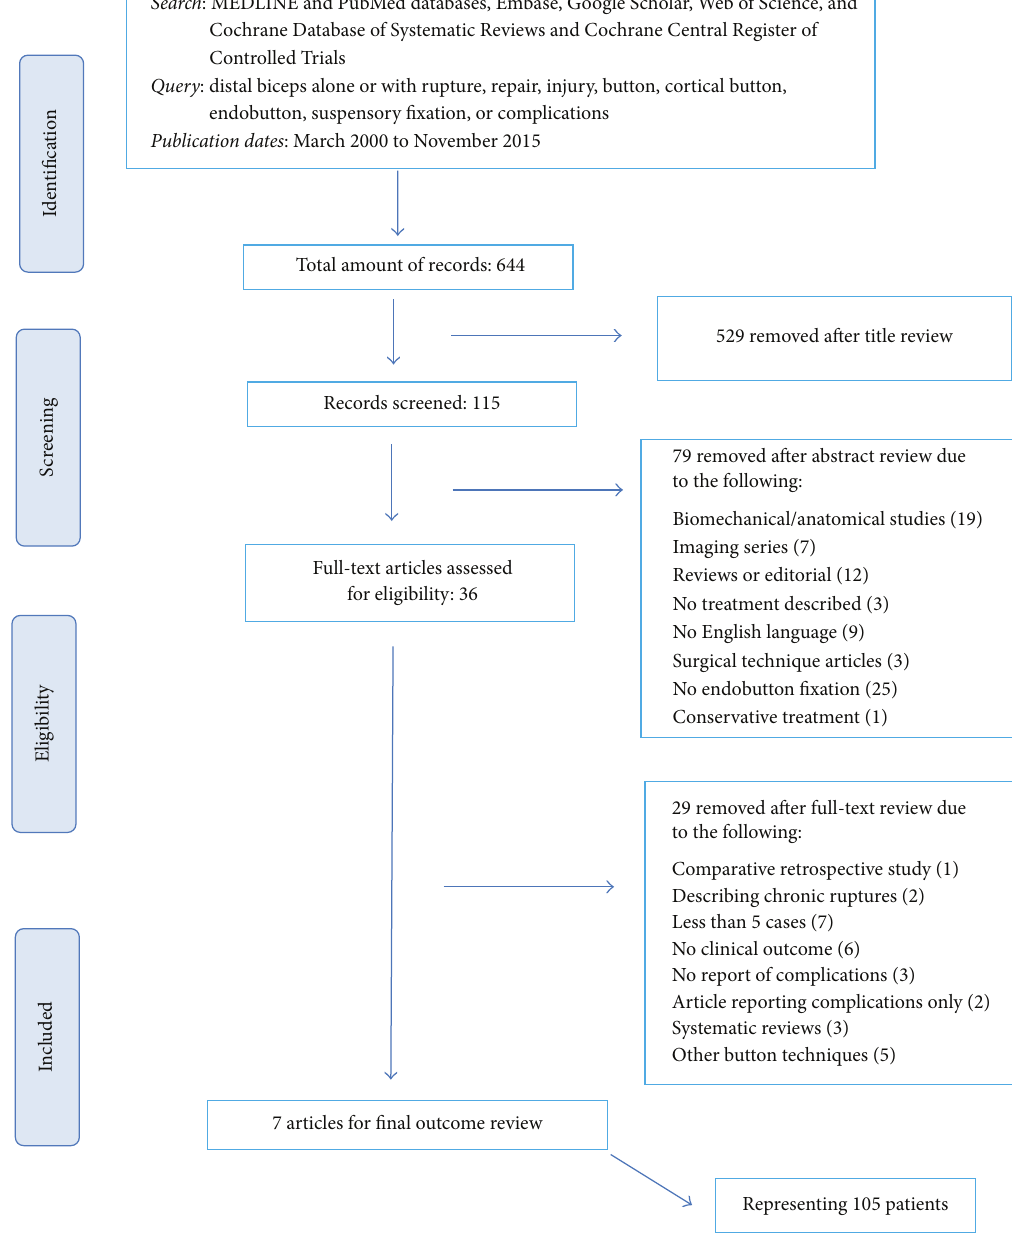
Figure 1: Search methodology and flowchart of excluded